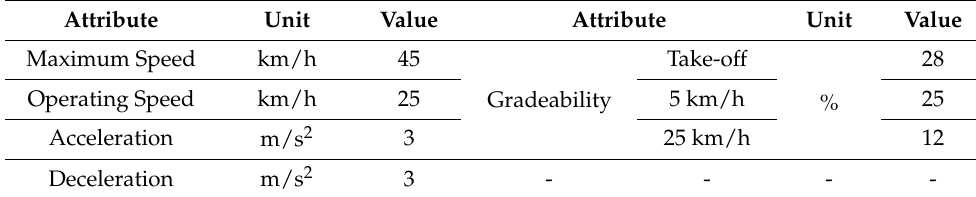
Table 1. Specifications of the target vehicle.